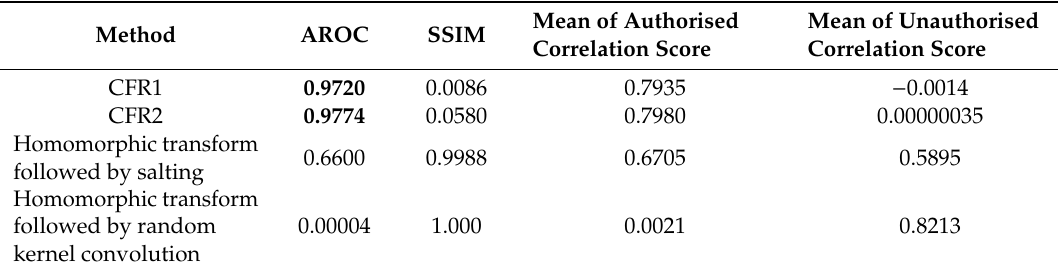
Table 1. Evaluation of CFR frameworks based on ORL dataset.